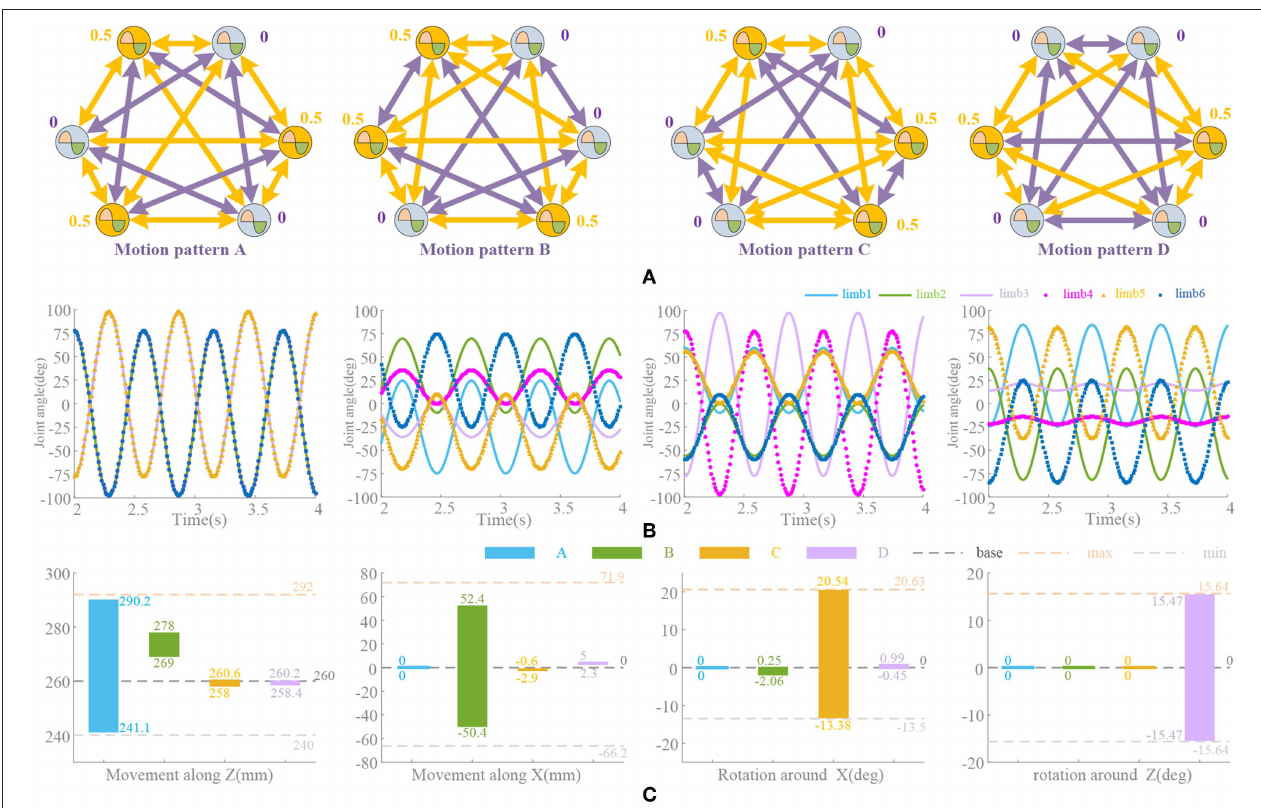
FIGURE 7 | Different motion patterns in different directions. (A) Network configuration. Coupling factors are set according to Materials and Method. Yellow arrows link oscillators with 180 ◦ phase difference. Phase factors ( ψ i = Φ i /2 π ) is marked. Purple arrows mean no phase difference. (B) Amplitude and offset of oscillation signals. (C) Deviations between neurobiologically inspired control and kinematics solution [the forward and inverse kinematics formula and structure parameters are shown in Appendix ( Supplementary Material )]. Movement along and around axial Y is not taken into consideration for the symmetry of structure and